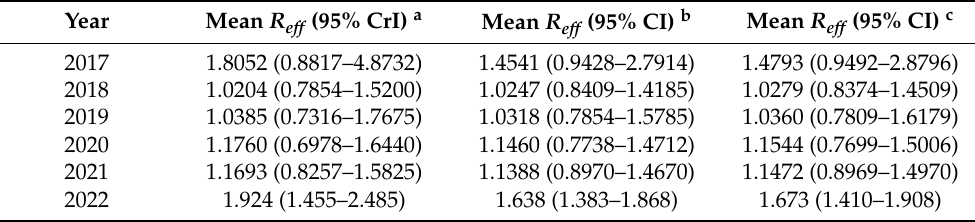
Table 1. Summary results of the mean of R eff estimates for MPXV for the data from 1 January 2017 to 27 August 2022.